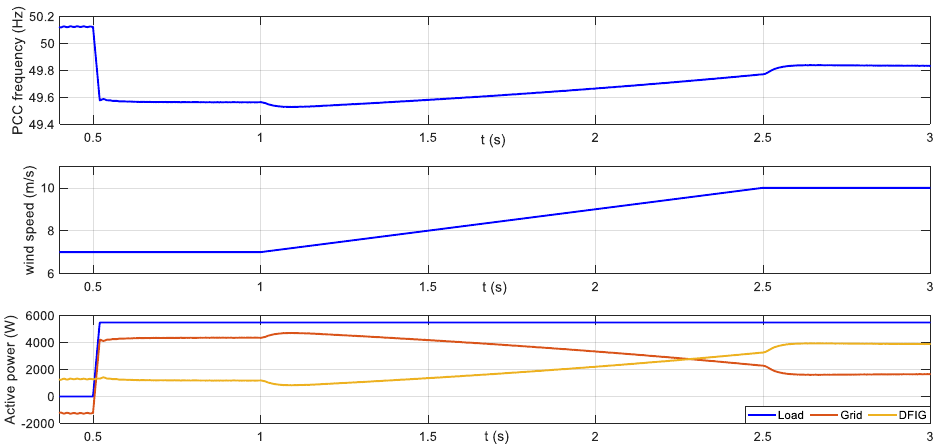
Figure 16. PCC frequency, wind speed and active power. Frequency drop compensation for the resistive load in the scheme of Figure 14.